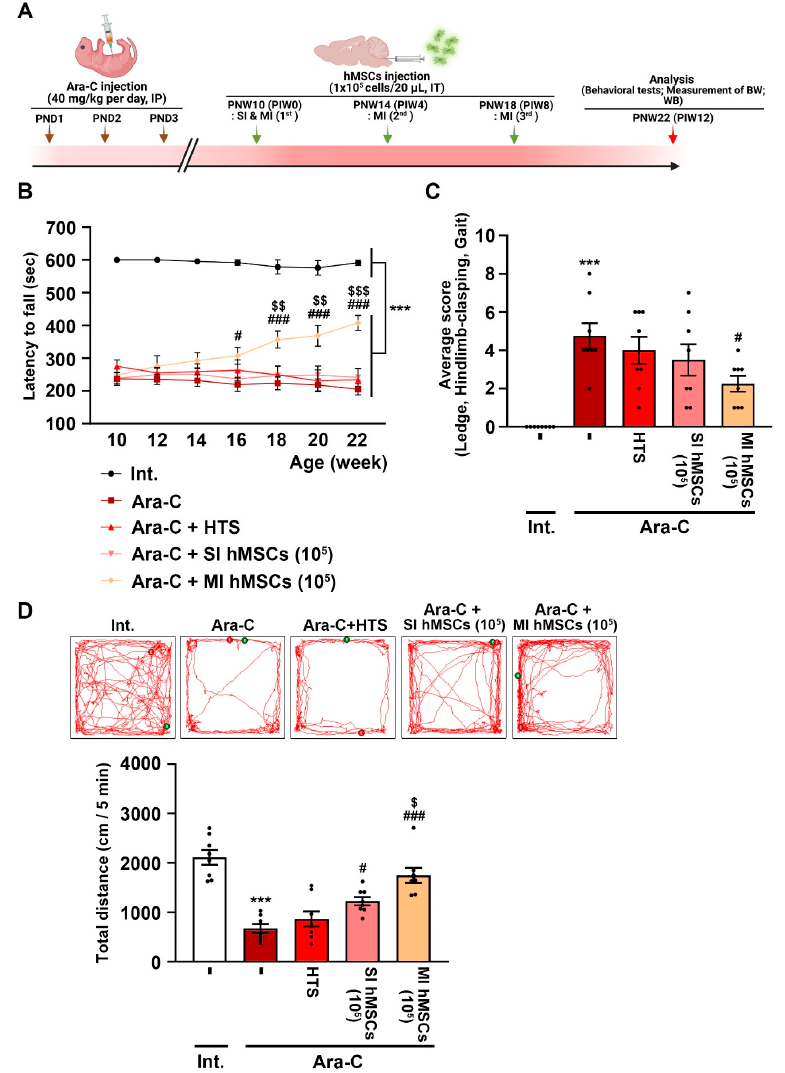
Figure 1. Beneficial effects of hMSCs on behavioral impairments in Ara-C-induced CA mice. ( A ) Experimental schematic of hMSC treatment in an Ara-C-induced CA mouse model. The figure was obtained using BioRender.com (Agreement number: FP24TP0Q0J). To establish a chemically induced animal model of CA, Ara-C (40 mg/kg/day) was intraperitoneally injected with a 0.3 mL syringe daily on postnatal days 1–3. The hMSC transplantation was performed once (single treatment) or thrice (multiple treatments) at 4-week intervals in 10-week-old Ara-C-induced CA mice. ( B ) A behavioral test for motor coordination impairment was performed using the rotarod test in the Ara-C-induced CA mice treated with hMSCs from 10 to 22 weeks of age at 2-week intervals. *** p < 0.001 vs. intact mice; # p < 0.05, ### p < 0.001 vs. Ara-C-induced CA mice; $$ p < 0.01, $$$ p < 0.001 vs. single hMSC treatment in Ara-C-induced CA mice (one-way analysis of variance (ANOVA) with Tukey’s post hoc analysis; n = 8 for each group). ( C ) A simple composite phenotype scoring system in the Ara-C-induced CA mice at 12 weeks after hMSC treatment. *** p < 0.001 vs. intact mice; # p < 0.05 vs. Ara-C-induced CA mice (one-way ANOVA with Tukey’s post hoc analysis; n = 8 for each group). ( D ) A behavioral test for locomotor activity was performed using the open-field test in the Ara-C-induced CA mice at 12 weeks after hMSC treatment. *** p < 0.001 vs. intact mice; # p < 0.05, ### p < 0.001 vs. Ara-C-induced CA mice; $ p < 0.05 vs. single hMSC treatment in Ara-C-induced CA mice (one-way ANOVA with Tukey’s post hoc analysis; n = 8 for each group). Int., intact; Ara-C, cytosine arabinoside; HTS, hypothermosol; hMSCs, human mesenchymal stem cells; SI, single injection; MI, multiple injection; PND, postnatal day; PNW, postnatal week; PIW, post implantation week (hMSC); IP, intraperitoneal injection; IT, intrathecal injection; CW, cerebellar weight; WB, Western